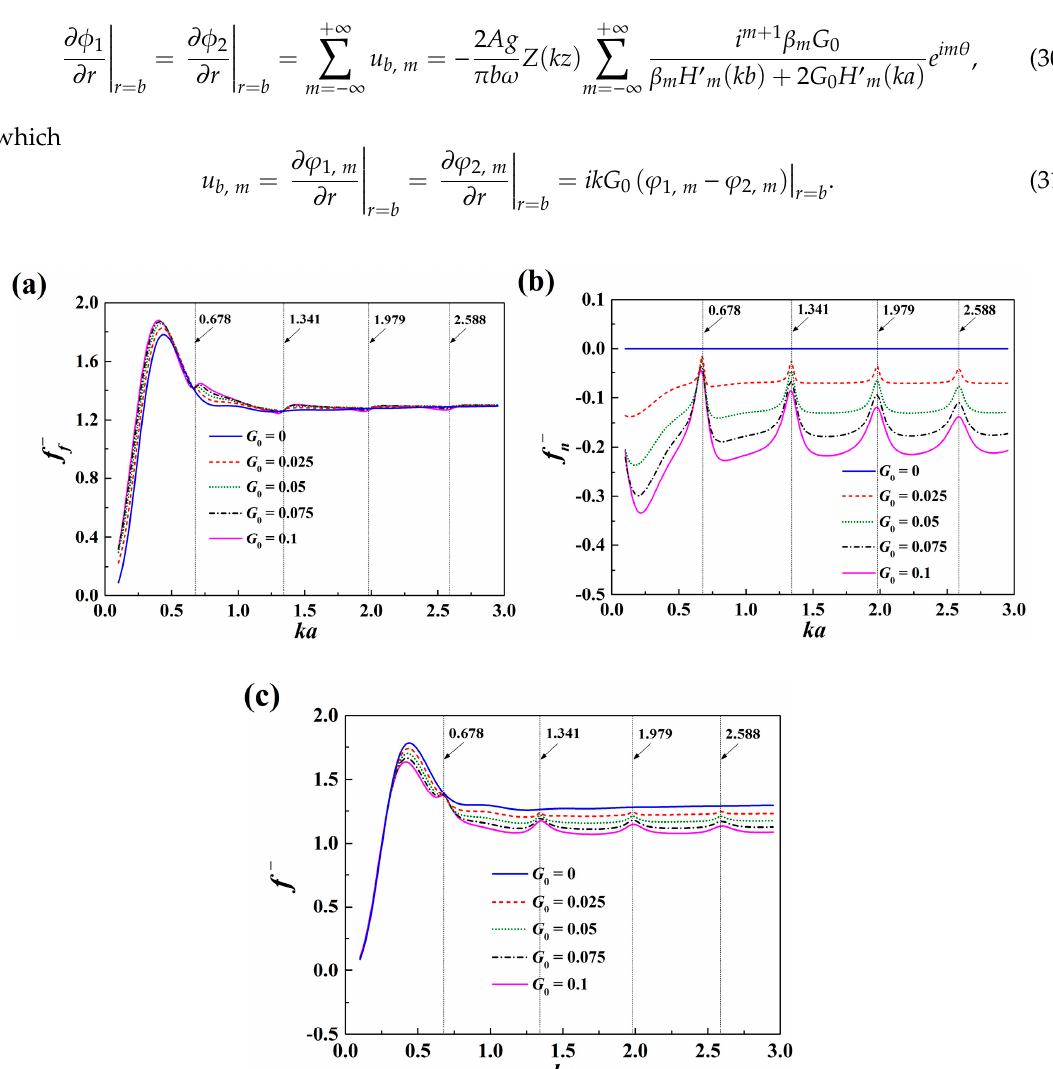
Commented [M3]: Please replace the original with this figure.